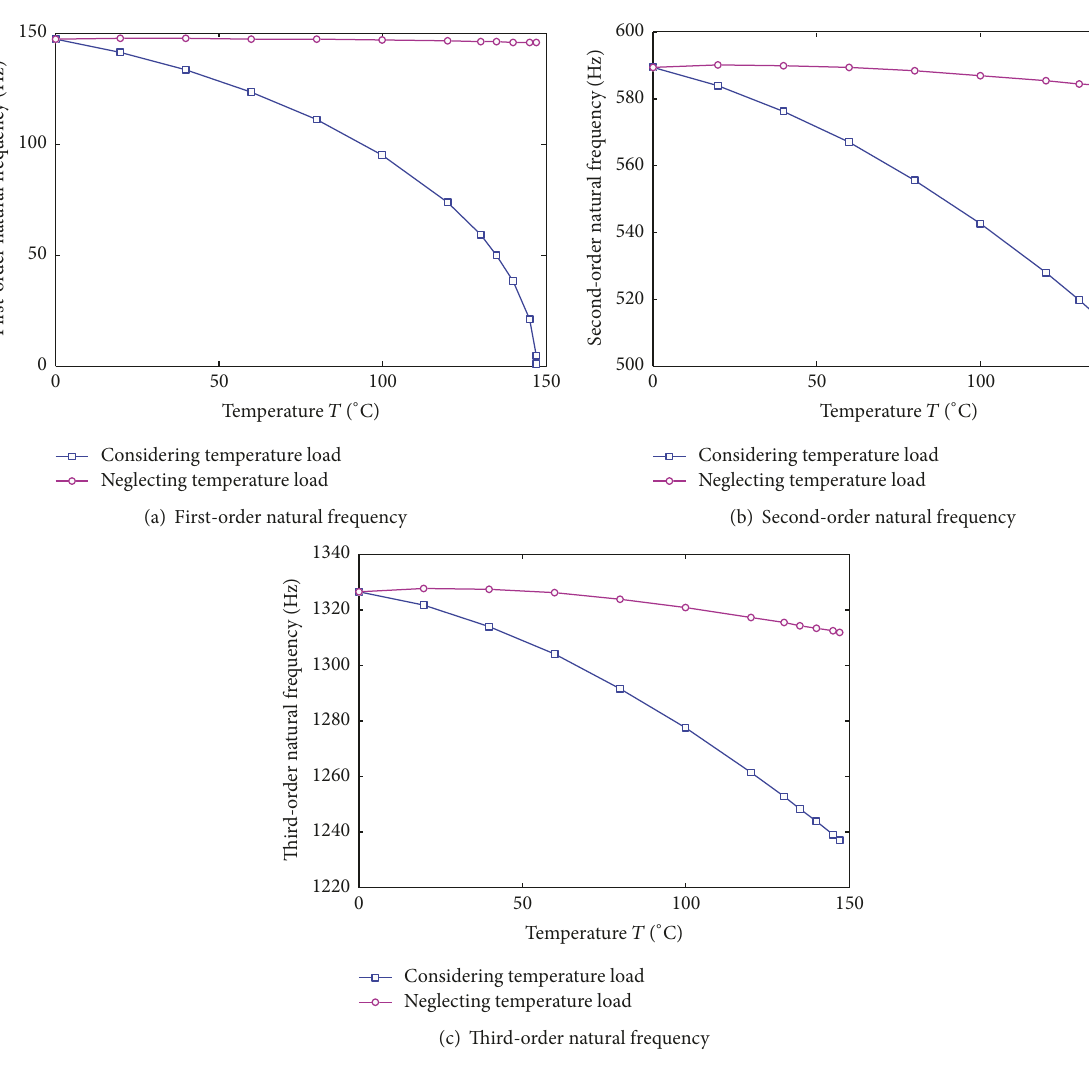
Figure 5: Comparison of the first three-order natural frequencies in two